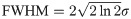
Relative thickness estimation error with respect to the error in BMDref.The true level of BMDref was 800, σ = 1.5, and c = 150 mg/mm, FWHM=22ln2σ. Note that with true BMDref both DM and MPA-methods produce no errors: the corresponding curves coincide with the x-axis.